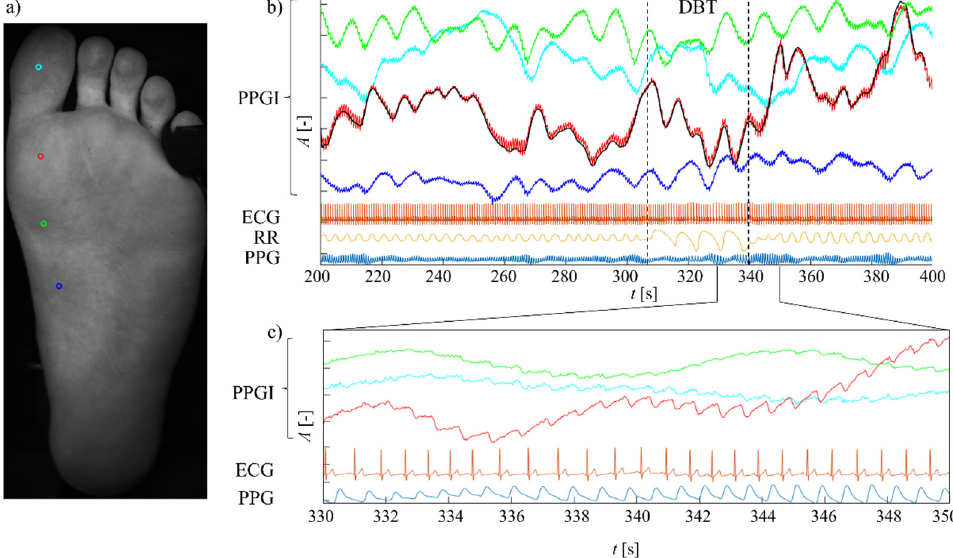
Figure 5. ( a ) Frame from the video record with marked points of signal extraction; ( b ) PPGI signals between 200 s and 400 s from different foot locations after tracking (colours of PPGI signals correspond to marked points on foot) together with signals obtained using the BIOPAC device (ECG, RR, PPG). The THD section is highlighted on the graph with black dashed horizontal lines; ( c ) zoom-in area from 330 s to 350 s of the recording (ECG, PPG, and 3 PPGI signals).